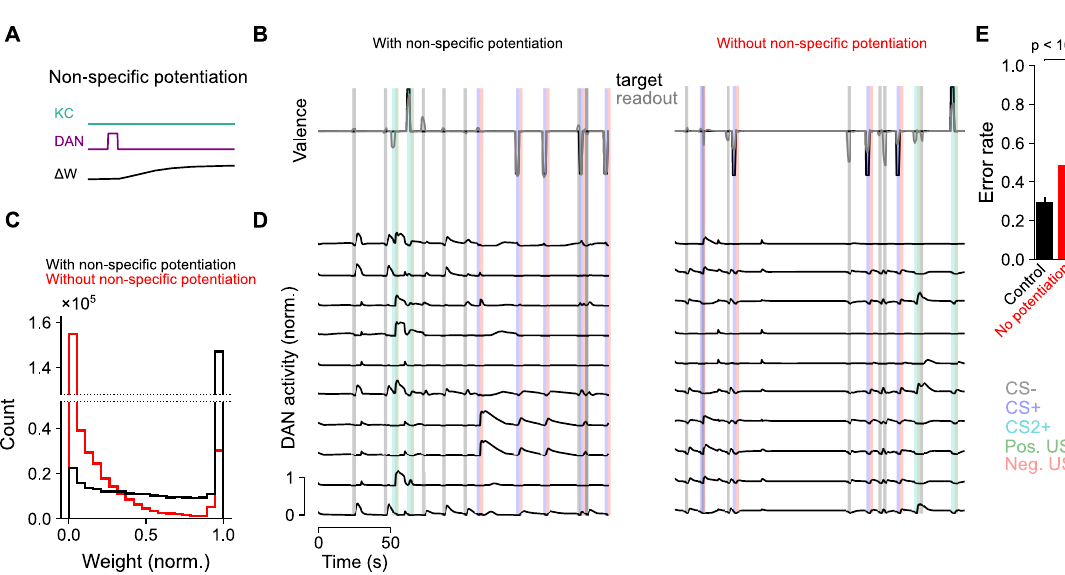
Fig 7. Model behavior for long sequences of associations. (A) Illustration of non-specific potentiation following dopamine neuron activity (compare with Fig 1C). (B) Example sequence of positive and negative associations between two odors CS+ and CS2+ and US. Neutral gray odors (CS-) are also presented randomly. (C) Histogram of synaptic weights after a long sequence of CS and US presentations for networks with (black) and without (red) non-specific potentiation. Weights are normalized to their maximum value. The means of the distributions across 18 network realizations for each condition were significantly different ( p < 2 � 10 − 7 , Mann- Whitney U -test). (D) Left: dopamine neuron responses for the sequence of CS and US presentations. Right: same as left, but for a network without non-specific potentiation. (E) Error rate (defined as a difference between reported and target valence with magnitude greater than 0.5 during a CS presentation; we used a higher threshold than Fig 3 due to the increased difficulty of the continual learning task) for networks with (black) and without (red) non-specific potentiation. Error rates for each network realization are evaluated over 20 test trials and used to generate p -values with a Mann-Whitney U -test over 18 network realizations.